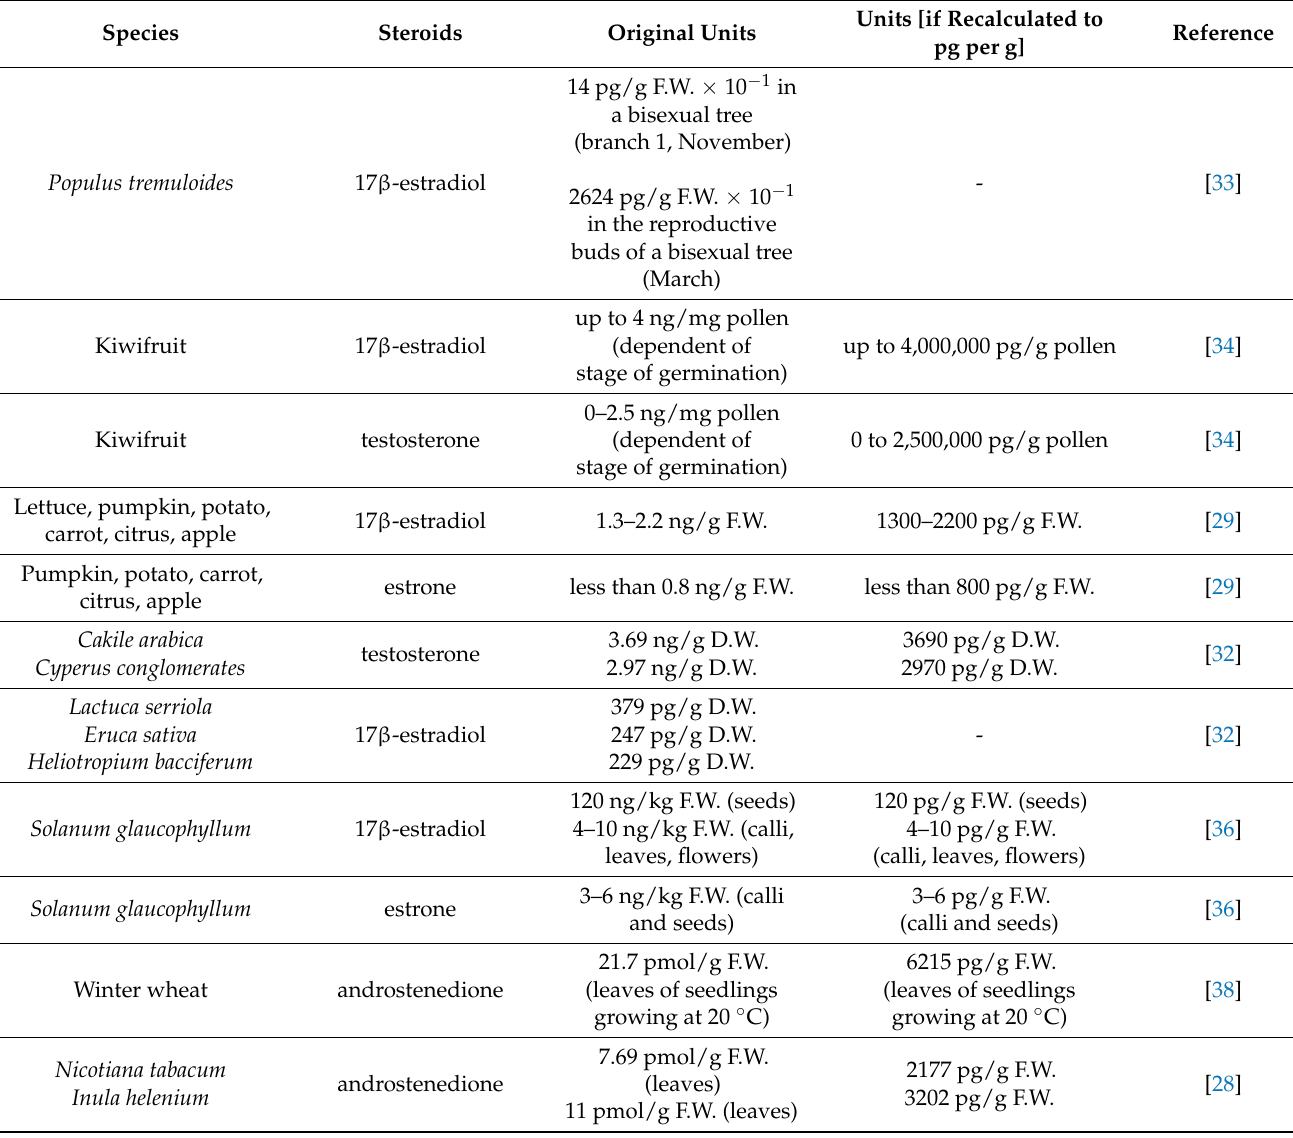
Table 1. Exemplary results of analysis of estrogens and androgens in plants (last 20 years). For better comparison of results, original units were recalculated/unified to pg per g of plant material (if necessary). F.W.—fresh weight; D.W.—dry